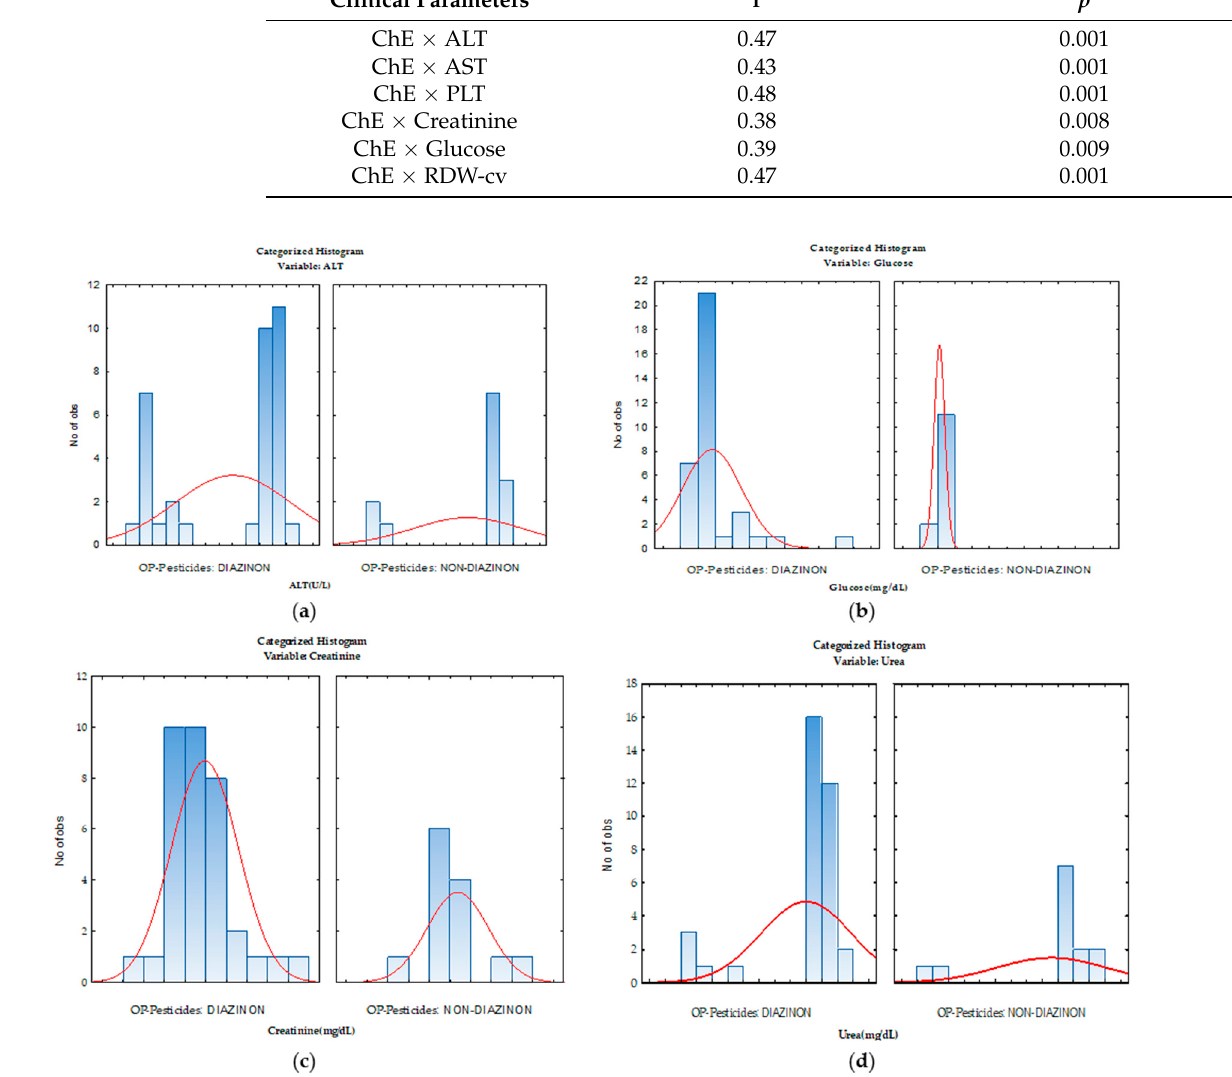
Figure 1. Distribution of ALT ( a ), glucose ( b ), creatinine ( c ), and urea ( d ) concentrations by incrimi- nated substance (diazinon/non-diazinon